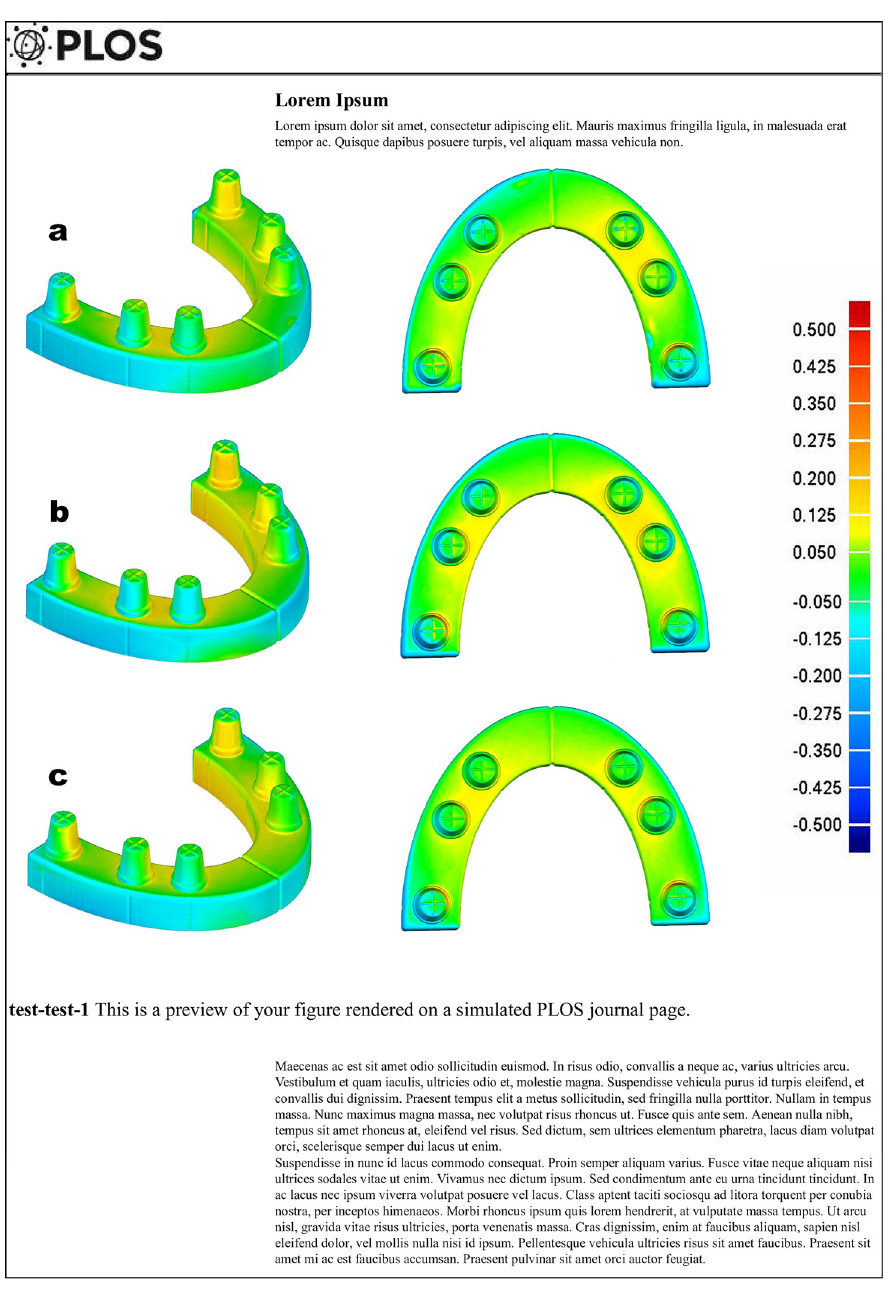
Fig 2. Typical deviation pattern between tested stone models and master model (trueness). The deviation range is color-coded from +500 μ m (dark red) to − 500 μ m (dark blue). Maximum/minimum nominal ± 50 μ m (green). Yellow through red color code indicates that, stone model is larger than the master model; light blue through dark blue color code indicates that, stone model is smaller than the master model; green surfaces present deviations ranging between 0 to ± 50 μ m. (a) BC, (b) EM, (c)